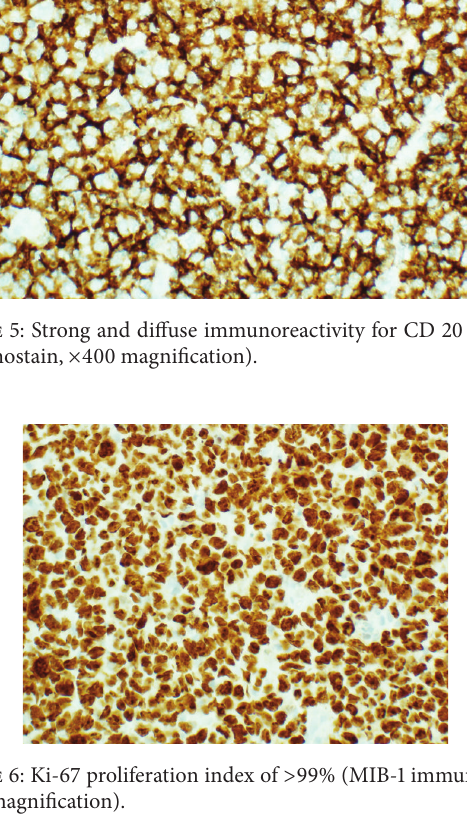
lymphoma; hence, our final diagnosis was primary Burkitt lymphoma of the